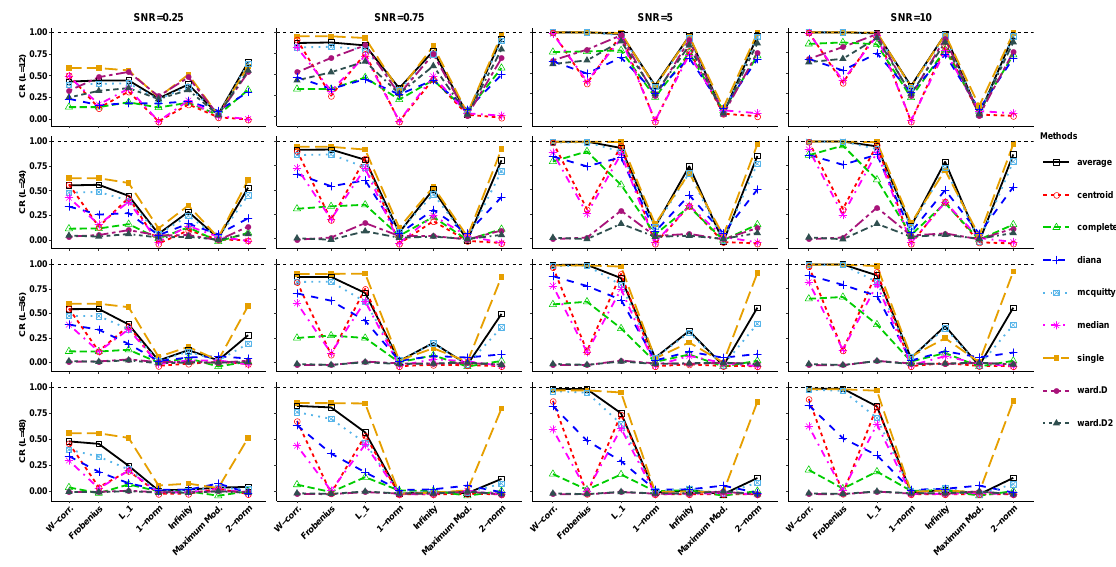
Figure 6. CR index for the Exponential × sine series (case e).